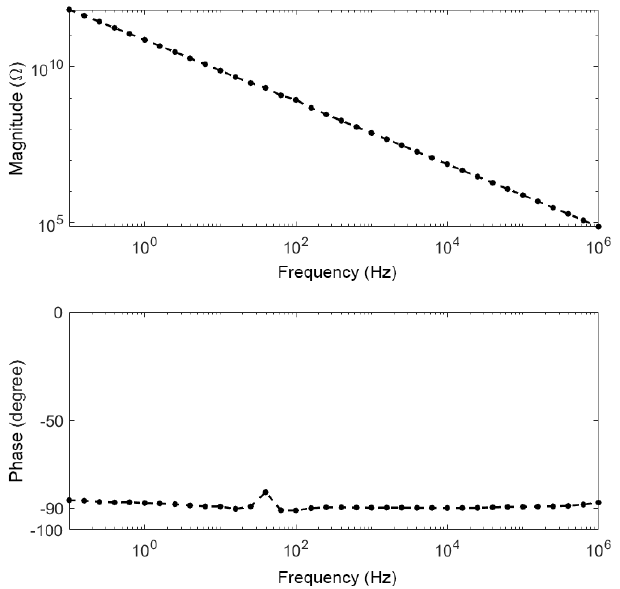
Figure 2. Magnitude of the sensor at room temperature in dry air. The outlier represents 50Hz noise.